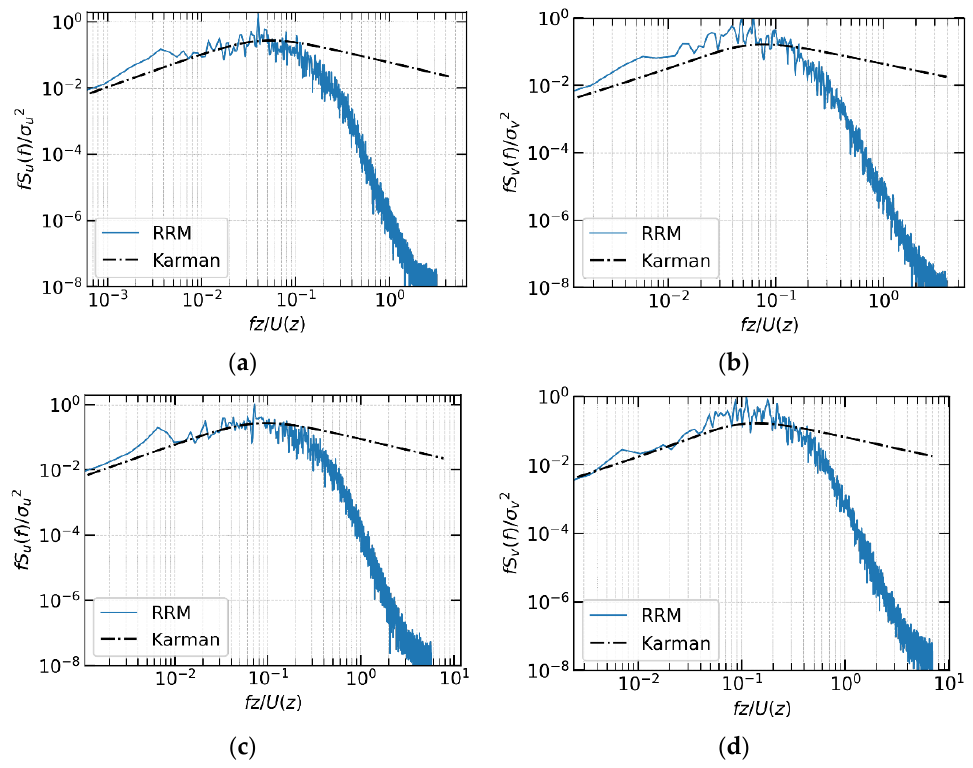
Figure 10. Power spectrum of longitudinal (left side, ( a ) Height = 0.05 m, ( c ) Height = 0.10 m) and cross (right side, ( b ) Height = 0.05 m, ( d ) Height = 0.10 m) fluctuating wind components.